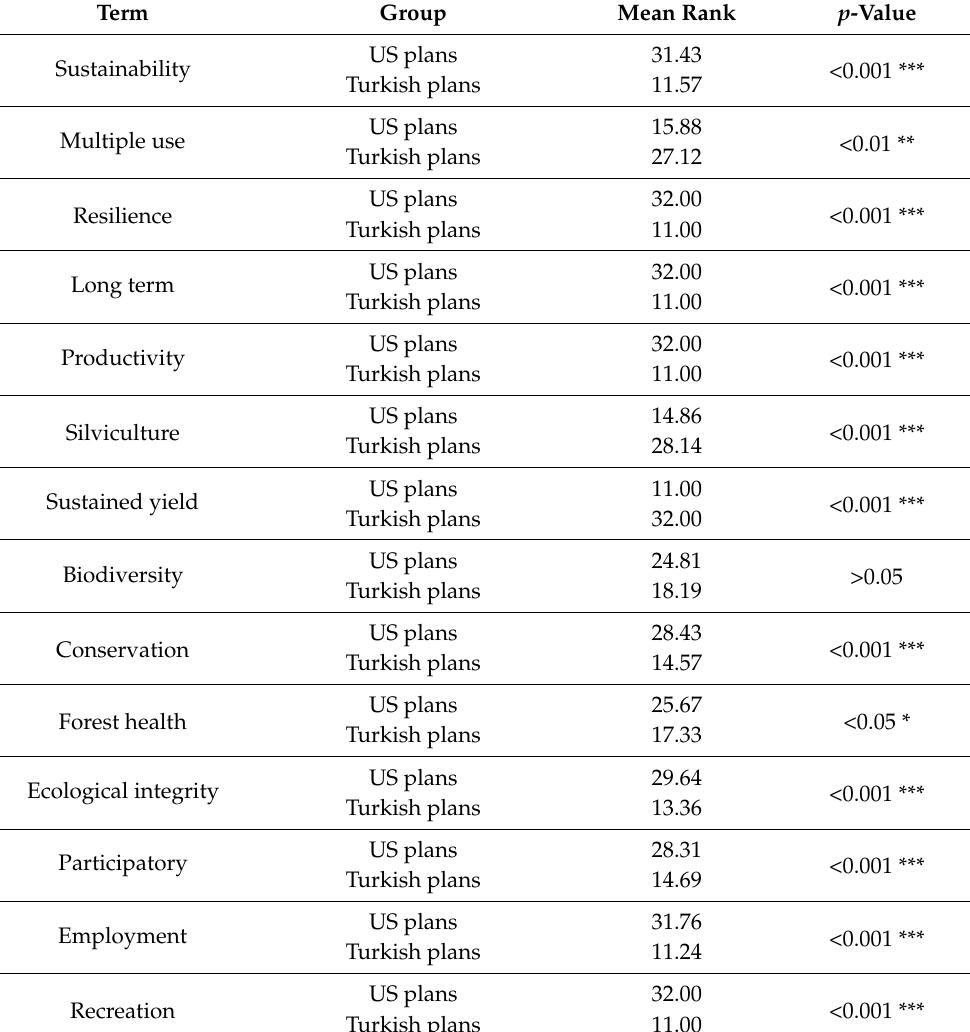
Table 4. Mann–Whitney U test results for individual terms associated with forest